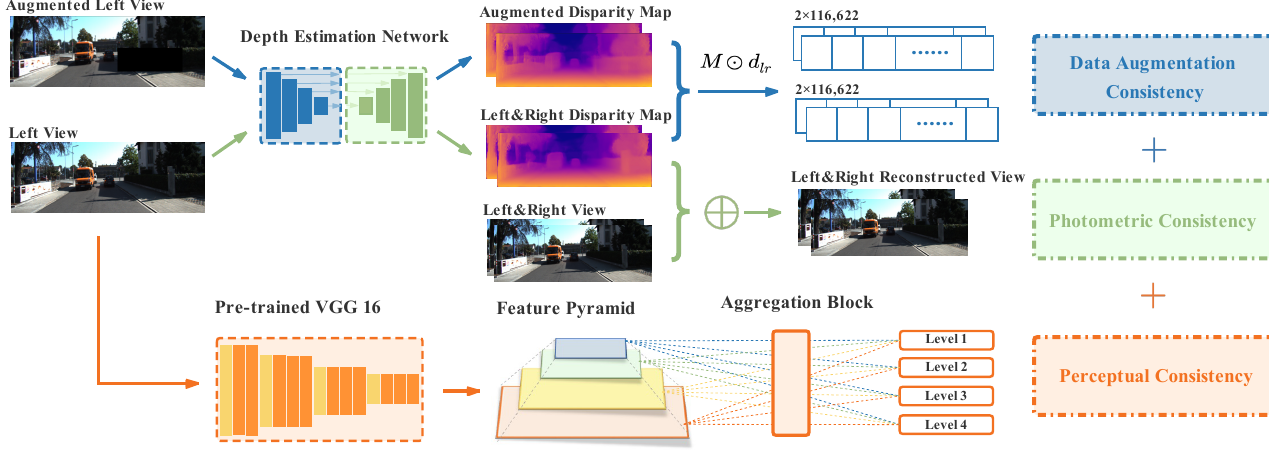
Figure 3. Illustration of the overall architecture of PDANet, which consists of three components: data augmentation consistency, photometric consistency, and perceptual